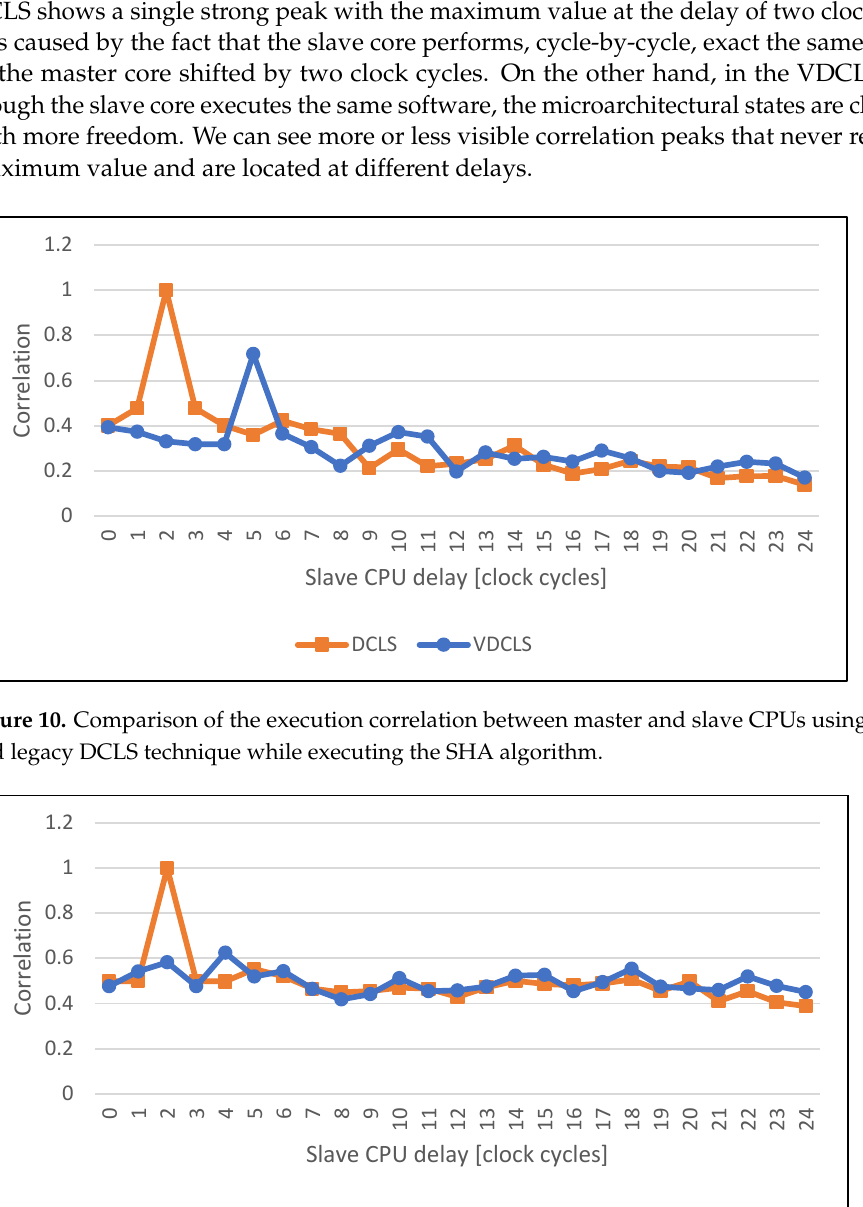
Figure 11. Comparison of the execution correlation between master and slave CPUs using VDCLS and legacy DCLS technique while executing the HMAC-SHA algorithm.